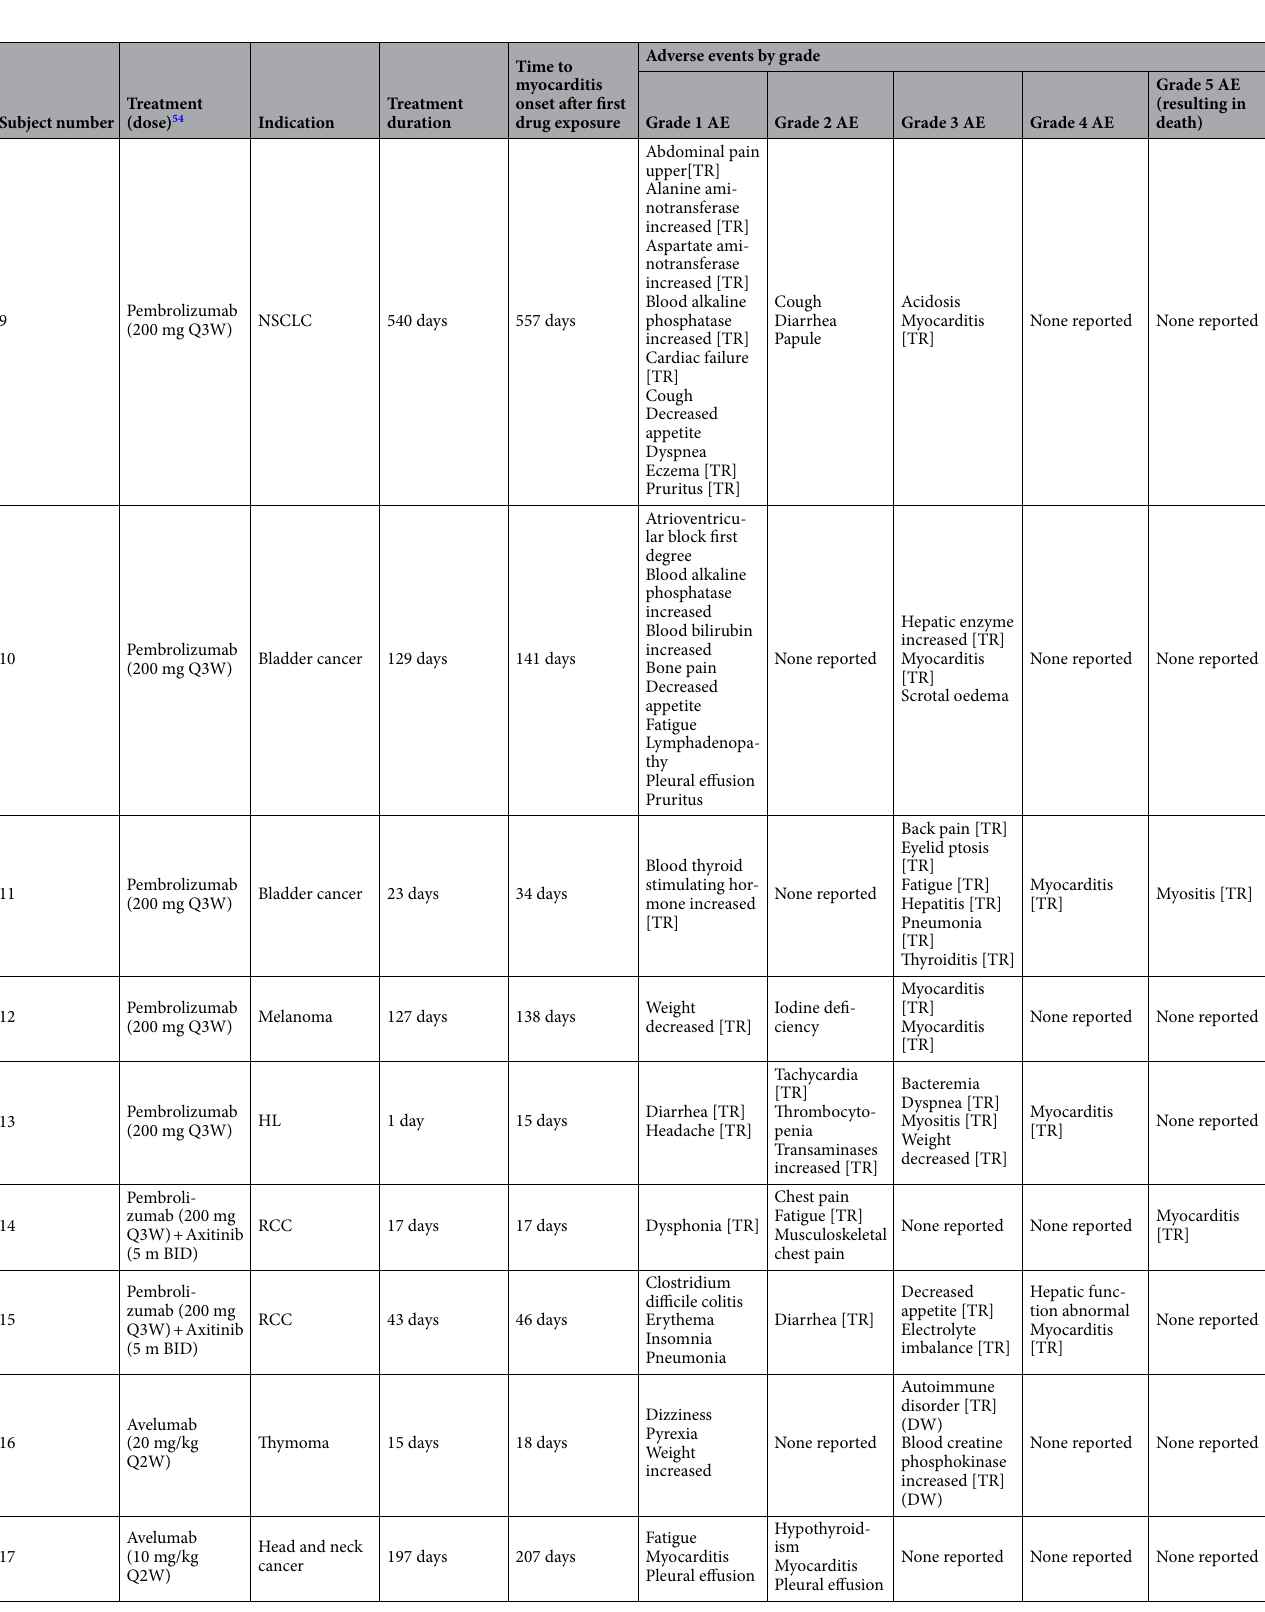
Table 2. Case series. [+++] = Certain AERELL; [++] = Probable AERELL; [+] = Possible AERELL; [TR] = Treatment related, plausibility unspecified. DR dose reduced, DW drug withdrawn, DD dose delayed. Cases are part of the approval packages for the listed ICIs (see